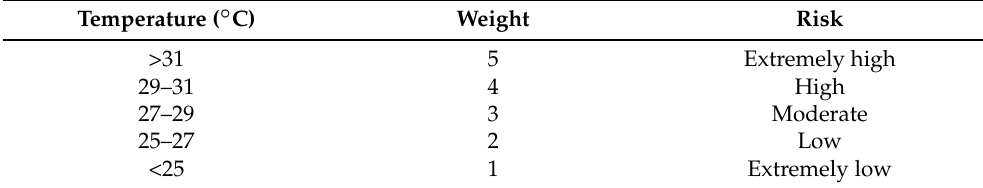
Figure 7. The base map of temperature in Laoshan. Each level is determined by the fire risk classification. Table 6. Fire risk classification of